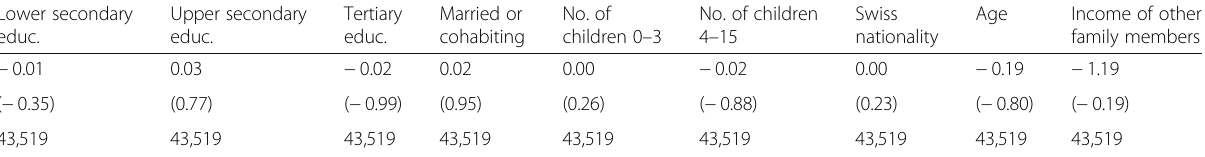
Table 5 Difference-in-differences estimates of the impact of the reform on the socio-demographic characteristics of mothers Lower secondary educ.